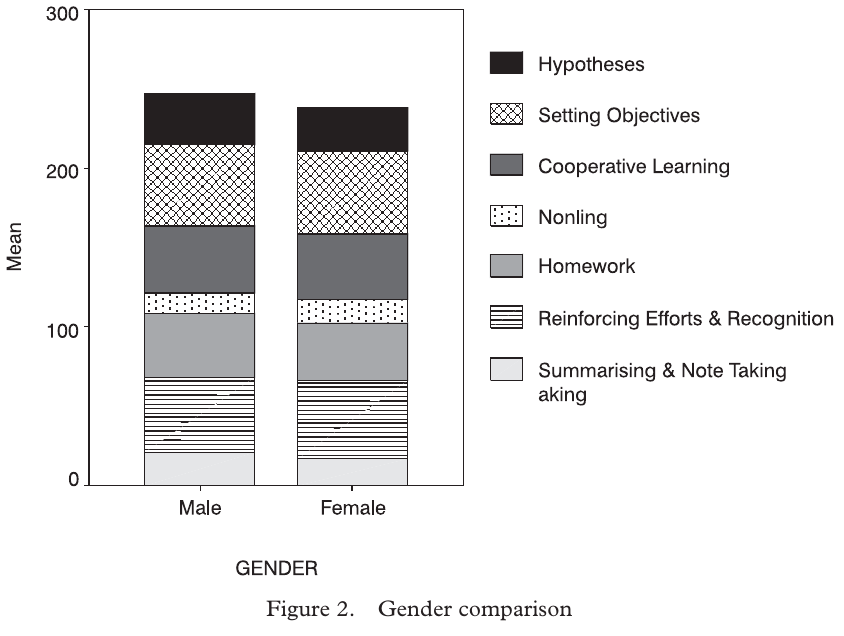
Figure 2. Gender comparison The same was applicable for the two remaining clusters and no difference was found (Figure 3). Therefore the use of e-learning pedagogies within our context appears to be gender-neutral. Figure 3. Comparison across genders